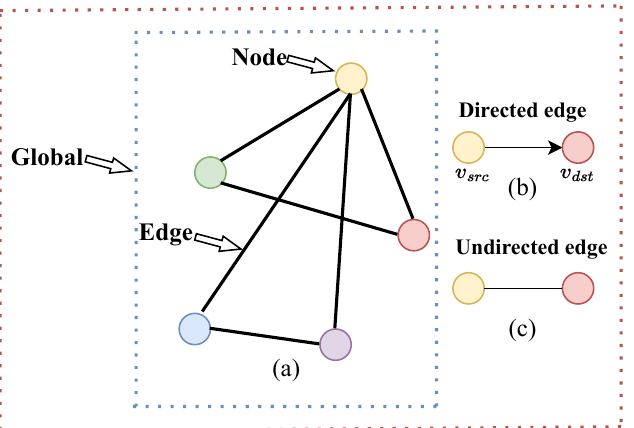
Figure 2. ( a ) The coloured circles represent node attributes, the lines between two circles represent edge attributes, and the whole graph represents the global attribute. In ( b , c ), there are directed and undirected edges to distinguish different graphs. The edges can be directed, where an edge e has a source node v src and a destination node v dst . In this case, information flows from v src to v dst . They can also be undirected, where there is no notion of source or destination nodes, and information flows in both